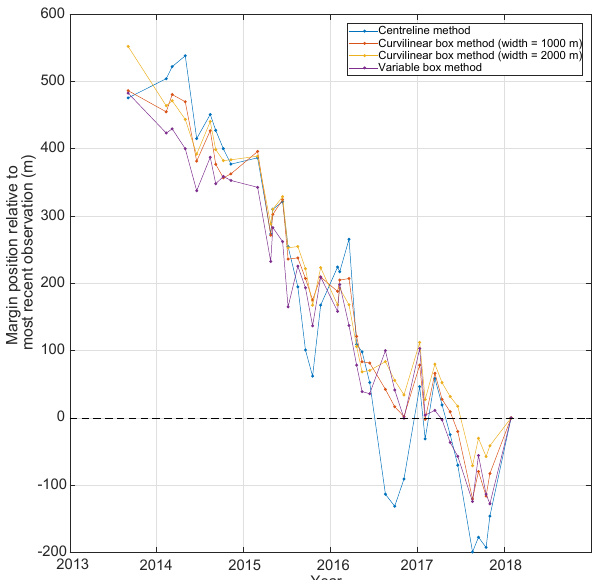
Figure 3. Intercomparison of monthly margin positions at Breiðamerkurjökull given by the curvilinear box method (width: 2000m) digitised from different satellites.